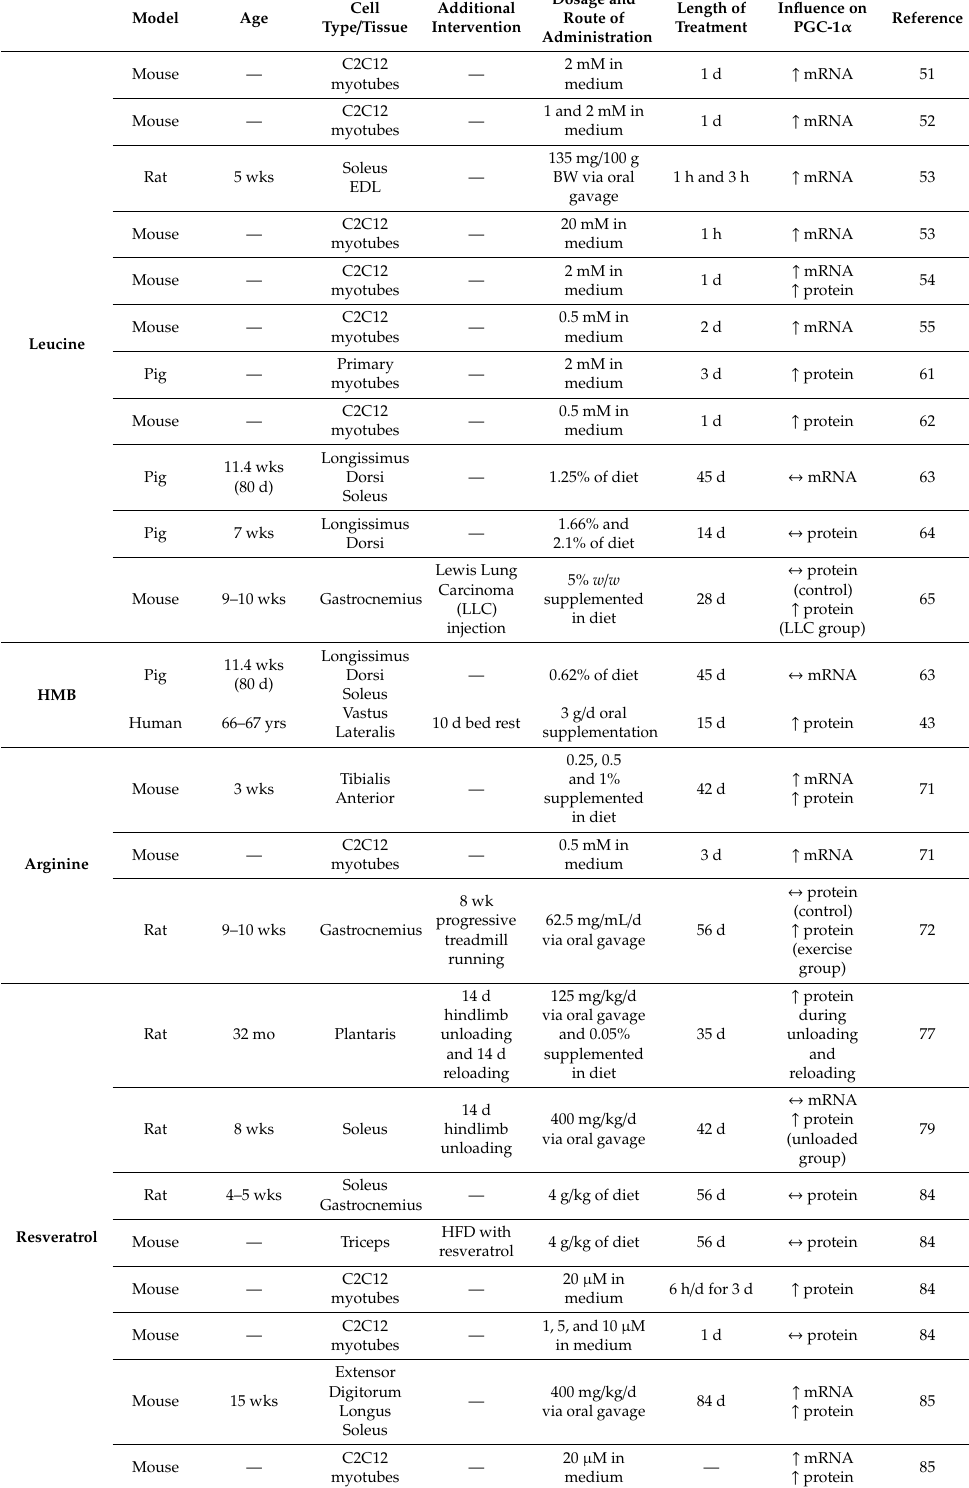
Table 1. Summary table of potential therapeutic approaches to influence muscle PGC-1 α .